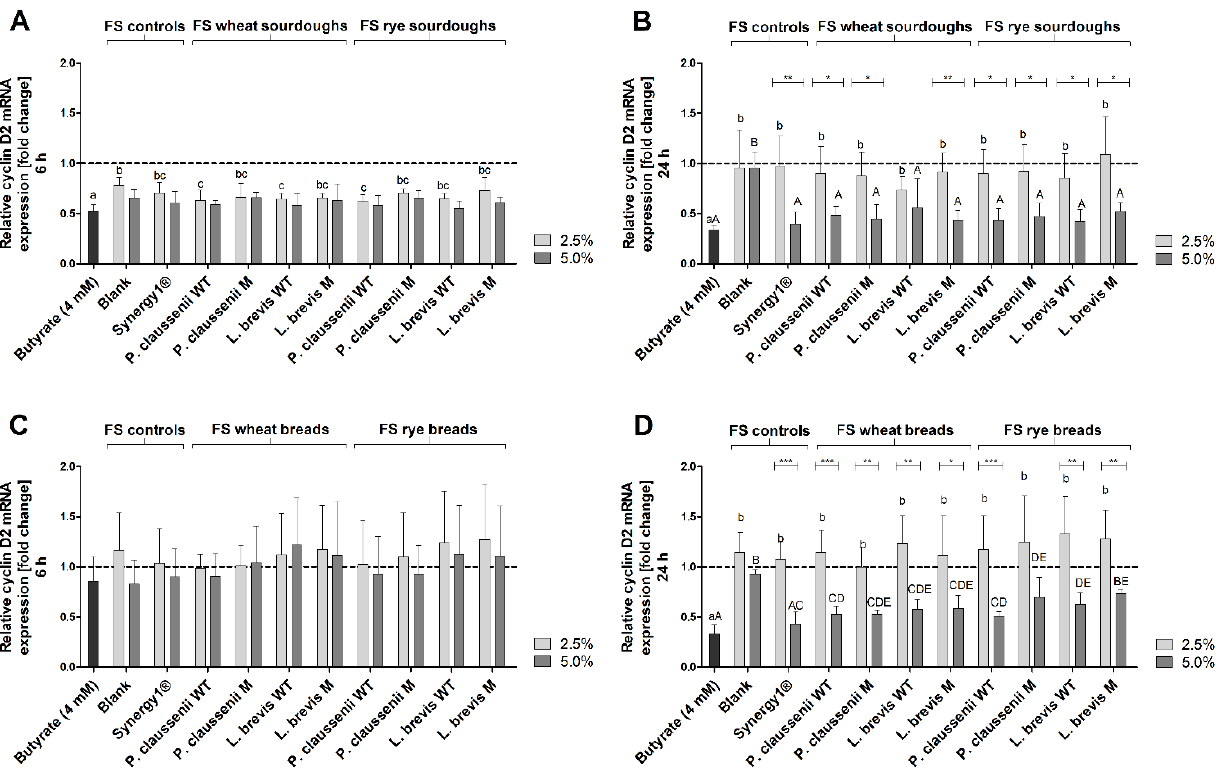
Figure 8. Relative cyclin D2 mRNA expression in LT97 cells after treatment with 2.5% and 5% fermentation supernatants (FS) obtained from controls (blank, Synergy1 ® ) and wheat and rye sourdoughs, as well as 4 mM butyrate for 6 h ( A ) and 24 h ( B ) and with FS obtained from controls (blank, Synergy1 ® ) and wheat and rye breads as well as 4 mM butyrate for 6 h ( C ) and 24 h ( D ) (mean + SD, n = 4). Results are presented as fold changes based on a medium control, which was set 1 (dashed line). Sourdoughs and breads were generated using wild-type (WT) and mutant (M) strains of Pedi-